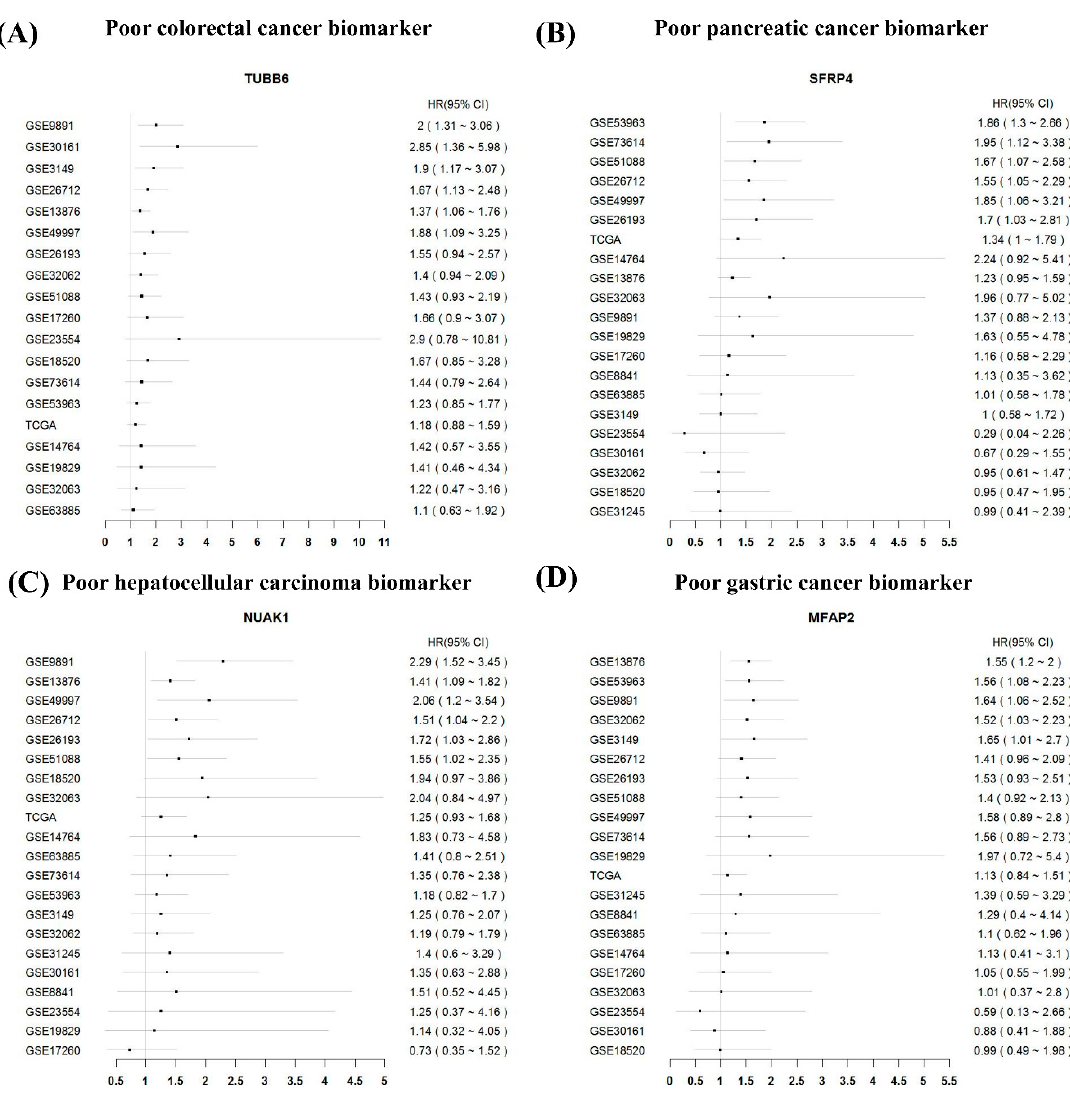
Figure 4. Excavation of potential prognostic biomarkers for ovarian cancer by OSov utilizing other tumor prognostic biomarkers. ( A ) TUBB6 gene in OSov (colon cancer biomarker); ( B ) SFRP4 gene